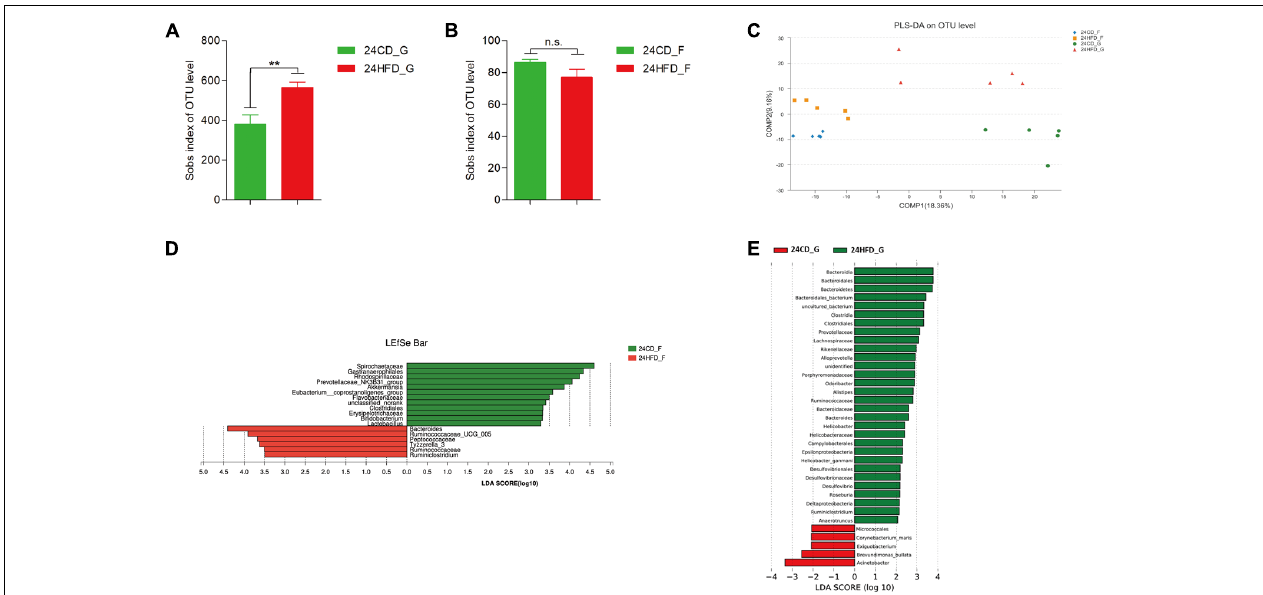
FIGURE 2 | The impact of HFD on the composition of gastric (G) and gut (F) microbiota in mice after 24 weeks ( n = 5 for each group). Alpha diversity was increased in 24HFD_G compared with 24CD_G (A) , while no significant difference was observed between 24HFD_F and 24CD_F (B) ( ∗∗ p < 0.01). (C) Partial least-squares discriminant analysis (PLS-DA) scores plot showed apparent distinctions between 24HFD_G (red) and 24CD_G (green) as well as 24HFD_F (yellow) and 24CD_F (blue). LEfSe analysis identified the most differentially abundant taxa between 24CD_F and 24HFD_F (D) as well as 24CD_G and 24HFD_G (E) . Only taxa meeting an LDA significant threshold of > 2 were